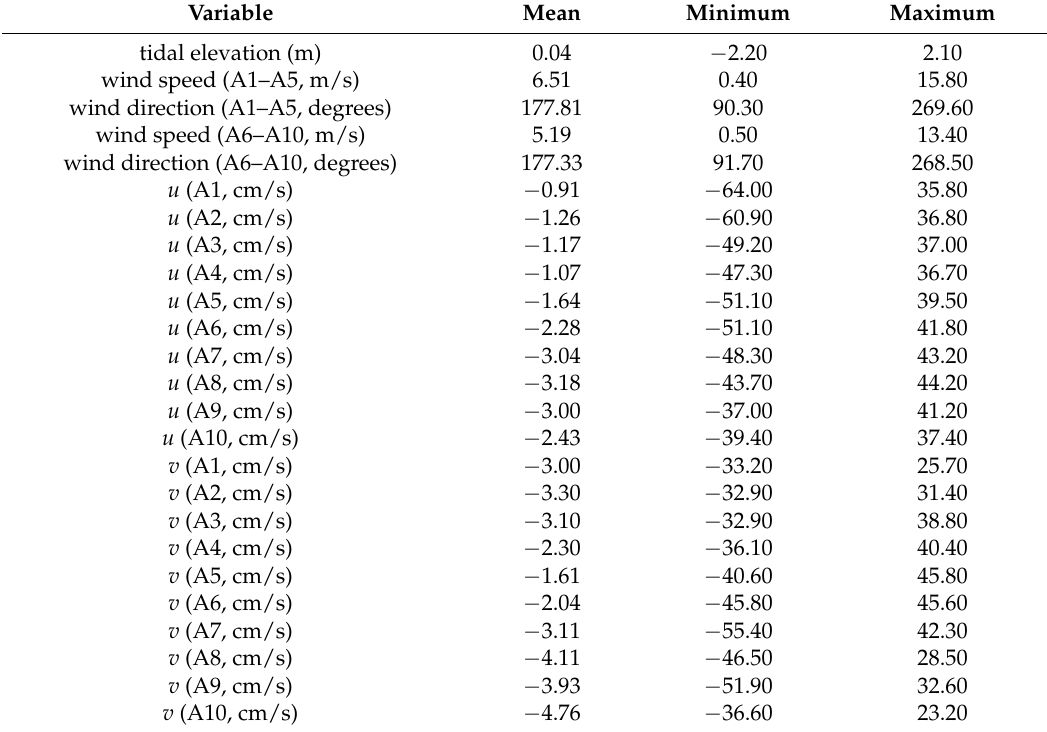
Table 2. Mean and range of testing dataset (20% of full dataset).